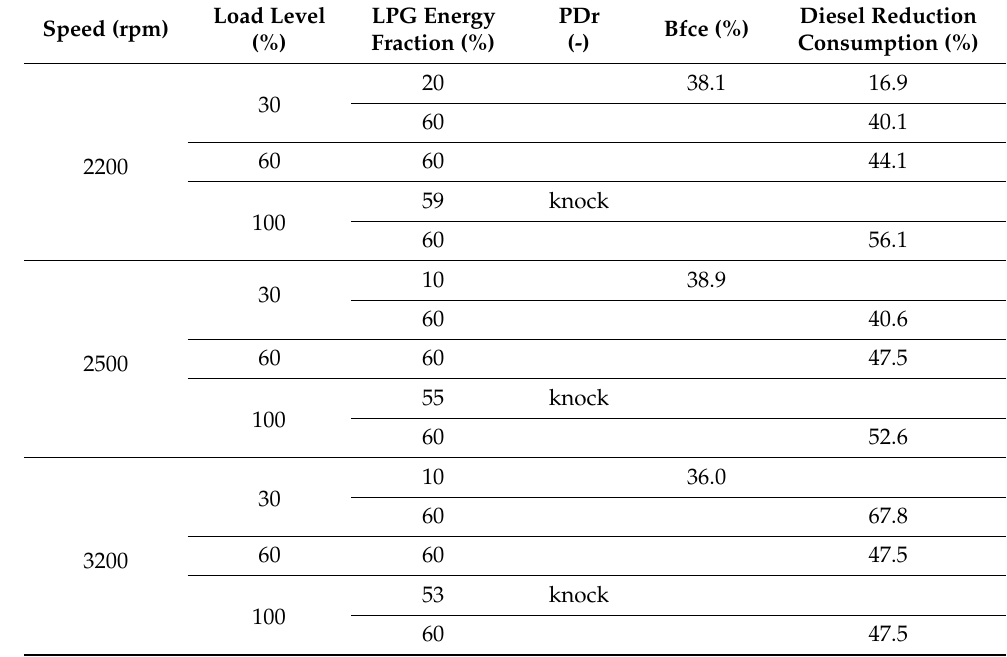
Table 3. Most important findings for PDr, Bfce and diesel reduction consumption for dual operation.